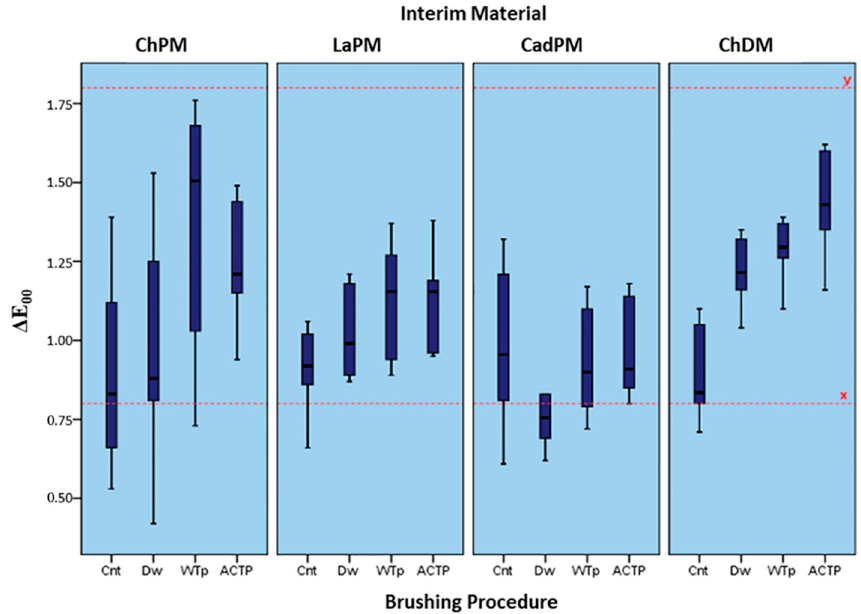
Figure 4. Mean ( ± SD) ∆ E 00 values of the test groups. The perceptibility threshold of the color Figure 4. Mean (±SD) Δ E 00 values of the test groups. The perceptibility threshold of the color differ- differences ( ∆ E 00 = 0.8) is indicated as line-x, and the acceptability threshold ( ∆ E 00 = 1.8) as line-y. ences ( Δ E 00 = 0.8) is indicated as line-x, and the acceptability threshold ( Δ E 00 = 1.8) as line-y. While the highest ∆ E 00 was observed for the ChDM_ACTp group (1.44 ± 0.16), the low- While the highest Δ E 00 was observed for the ChDM_ACTp group (1.44 ± 0.16), the est was observed for the CadPM_Dw group (0.79 ± 0.19). When the control groups lowest was observed for the CadPM_Dw group (0.79 ± 0.19). When the control groups were compared, no significant difference was observed between the interim crown mate- rials ( p > 0.05). The Δ E 00 values of WTp- or ACTp-applied ChPM and ChDM, and Dw- applied ChDM, were significantly higher than their control groups ( p < 0.05). No statisti- cally significant difference was found among the toothbrushing groups within the interim materials, except for the ChPM group ( p > 0.05). Brushing with the WTp and ACTp tooth-